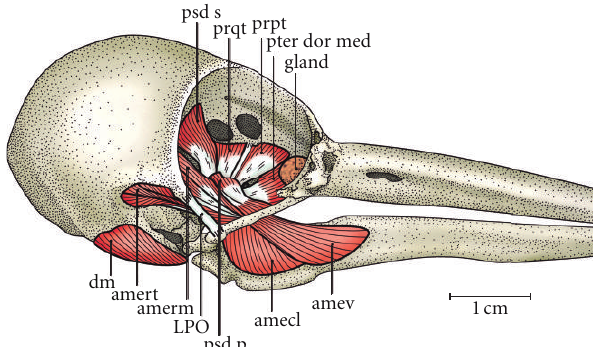
Figure 5: A lateral superficial view of the jaw muscles of Reindwardtipicus validus. amecl: adductor mandibulae externus caudalis lateralis;